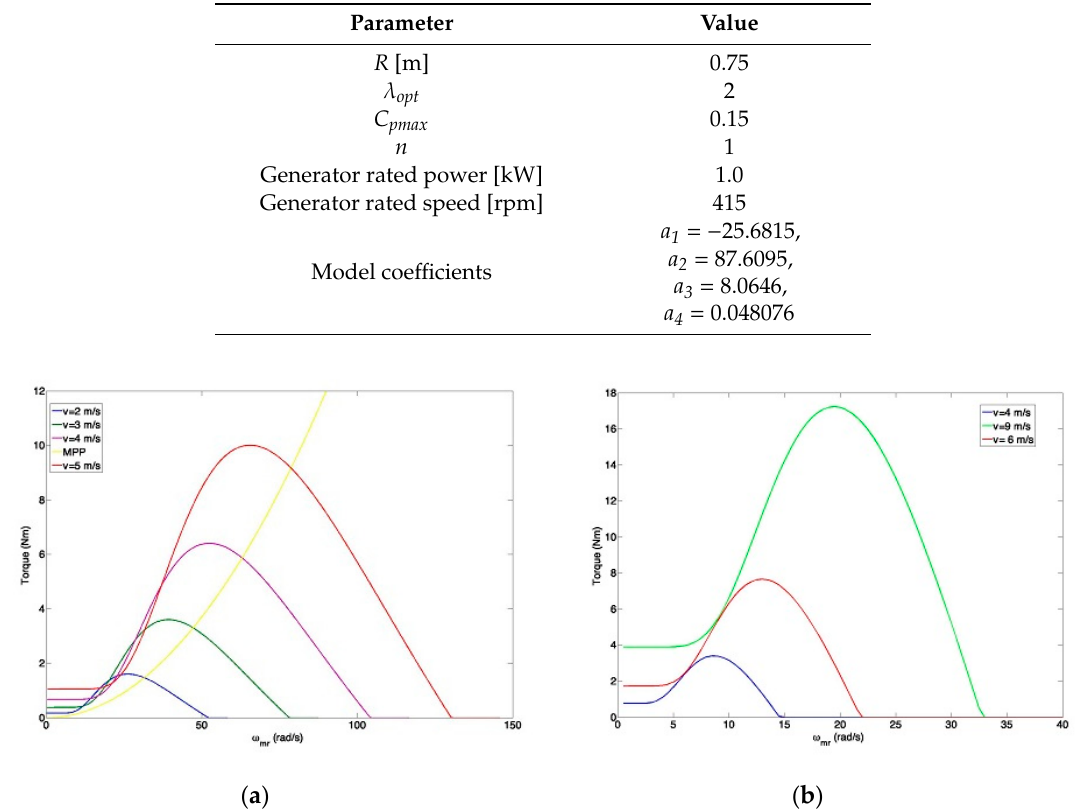
Figure 6. Torque versus speed characteristics for several wind speed values: ( a ) 5.5 kW horizontal axis wind turbine (HAWT) (locus of the MPPs in yellow); ( b ) 1 kW vertical axis wind turbine (VAWT).